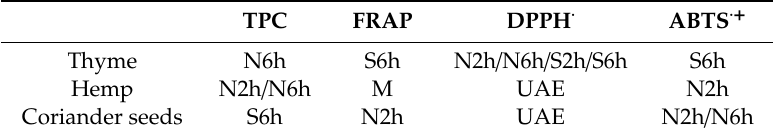
Table 5. Extracts with the highest value of total phenolic content and antioxidant activity TPC FRAP DPPH ˙ ABTS ˙ + Thyme N6h S6h N2h / N6h / S2h / S6h S6h Hemp N2h / N6h M UAE N2h Coriander seeds S6h N2h UAE N2h /